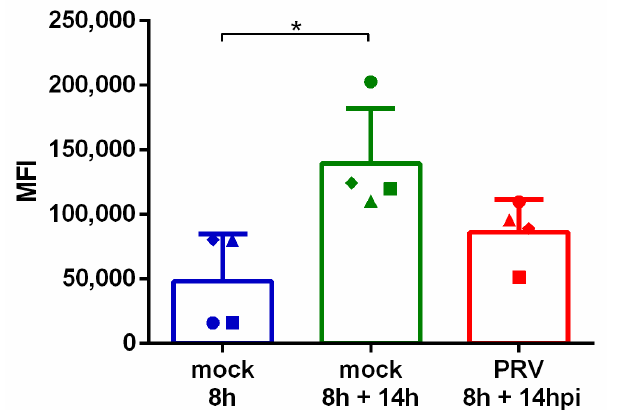
Figure 4. pULBP1 expression on the cell surface is reduced after PRV infection. SK cells were cultivated in suspension for 8 h before mock or PRV inoculation. At the indicated time points, pULBP1 expression on the cell surface was measured using flow cytometry. Graphs show the median fluorescence intensity (MFI) for each condition. Bars represent the mean value ± SD; different symbols correspond to individual data points from different independent repeats, n = 4. Statistically significant differences are indicated with asterisks (* p < 0.05).